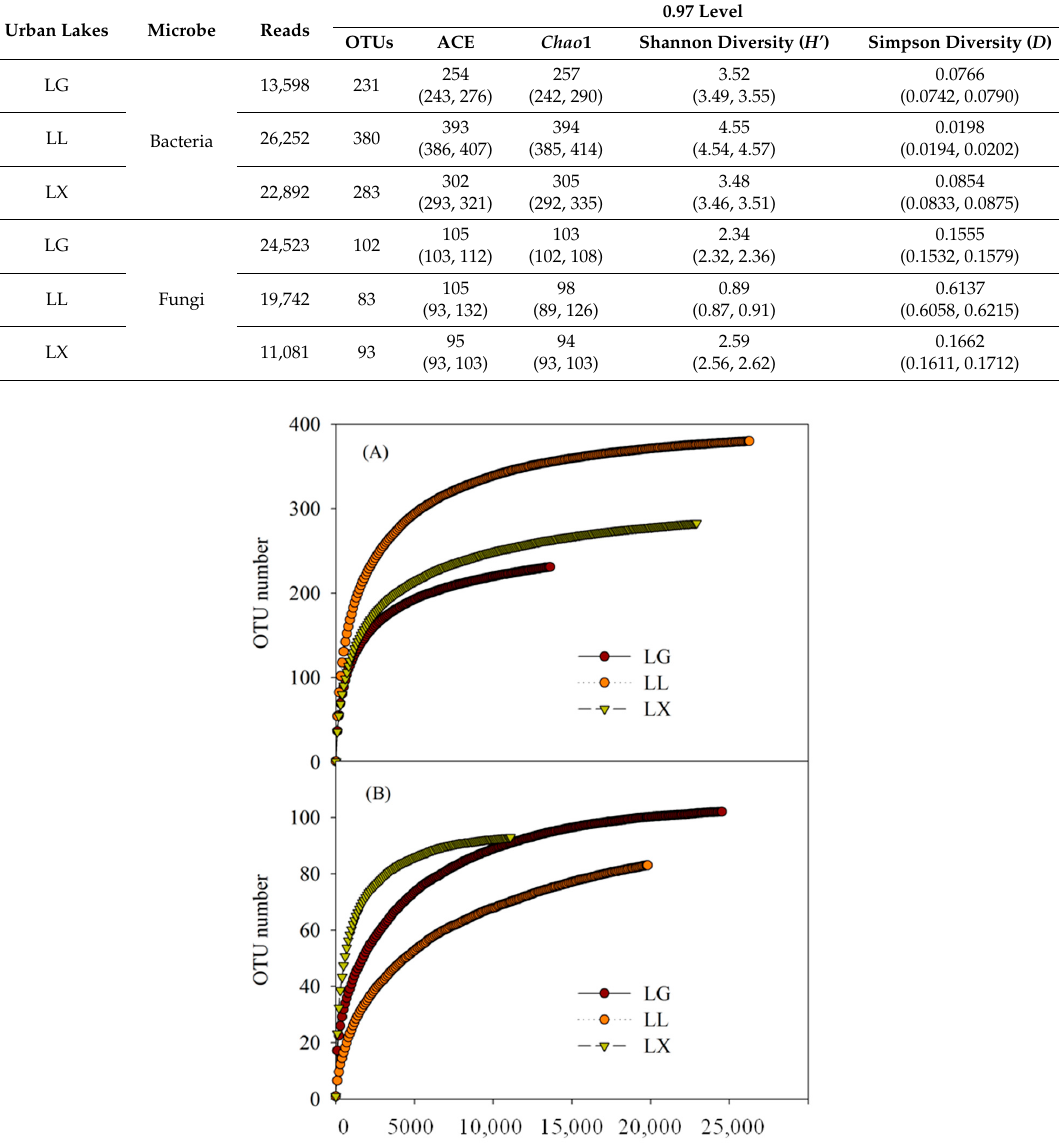
Figure 2. Water bacterial ( A ) and fungal ( B ) community operational taxonomic units (OTUs) number at 0.97 level and the reads number sampled based on Illumina Miseq data of Geming lake (LG), Lianhu lake (LL), and Xingqing lake (LX) in Xi’an City, Shaanxi Province, China.